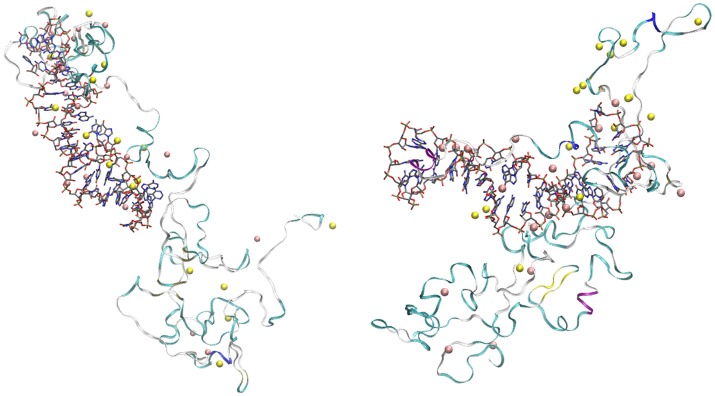
Final configurations of OPN-(OPN-R3) complexes in trajectories 1 (left) and 3 (right). OPN-R3 (RNA) is represented as sticks. The RNA loop is in the center (left) and on the left-hand side (right). OPN protein is represented as a ribbon with colors associated to secondary motifs identified by the STRIDE (Frishman and Argos, 1995) algorithm (α-helix is in magenta and blue, β-sheet is yellow, turns are in cyano, coils in white); Na ions are yellow spheres, Mg are pink spheres. Atomic and bond radii are arbitrary. The ions were selected as those within a distance of 0.28 nm from any atom of the solute complex. The number of ions (n1) is 18 for Mg (both configurations) and, respectively, 15 and 16 for Na in trajectory 1 (left) and 3 (right).